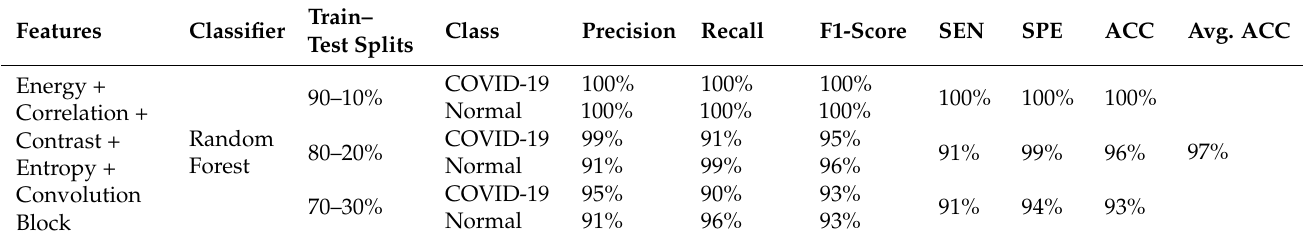
Table 5. Classification accuracy with different train–test